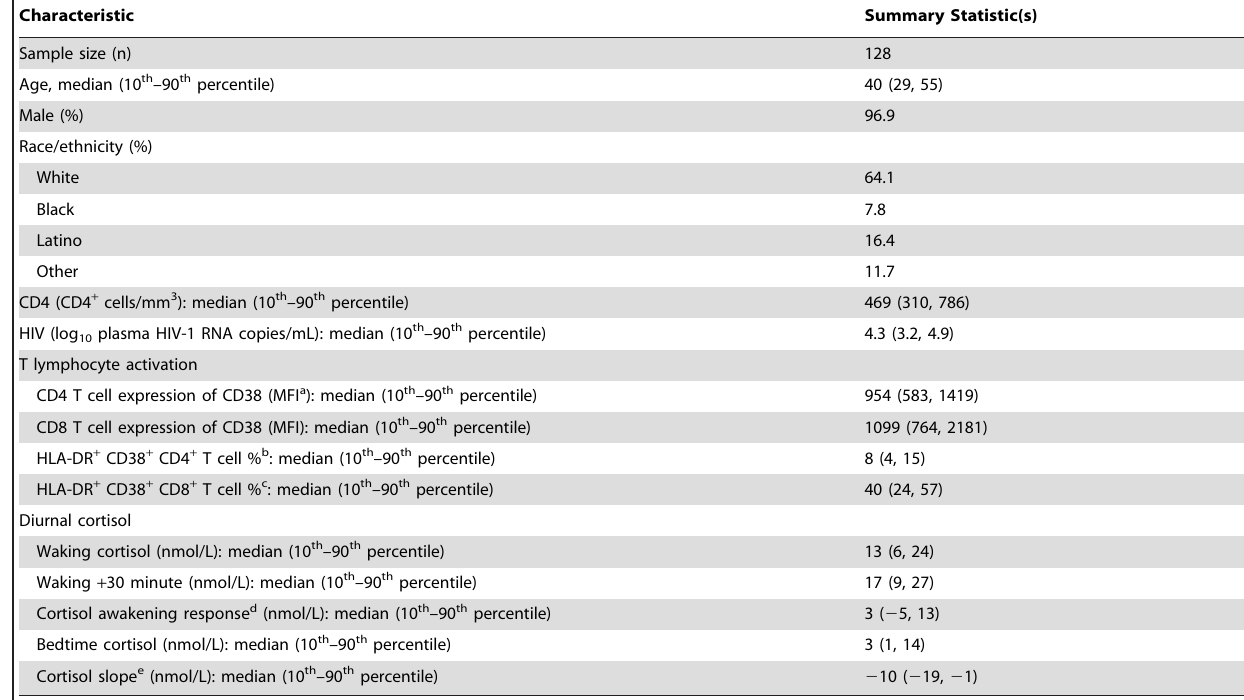
Table 1. Baseline descriptive